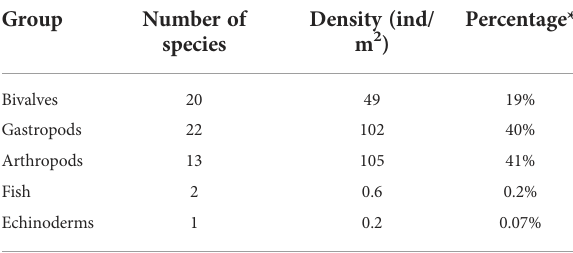
TABLE 3 Number of species, average density and the percentage of different marobenthic groups in mud fl ats of Tujiao in